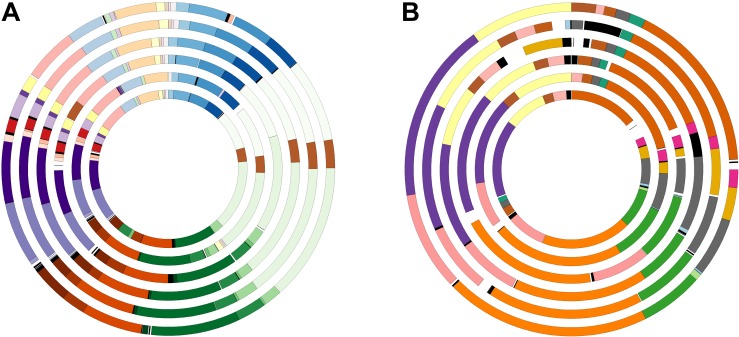
Salinivibrio large (87 LCBs) (A) and small (30 LCBs) (B) chromosomes circular plots. Each circle represents a genome. From the outer most circle: S. kushneri AL184T, S. costicola subsp. costicola LMG 11651T, S. costicola subsp. alcaliphilus DSM 16359T, S. proteolyticus DSM 19052T, S. sharmensis DSM 18182T, and S. siamensis JCM 14472T. LCBs in the same color are shared by all six strains, with the exception of LCBs in black which are shared by less than the six strains.